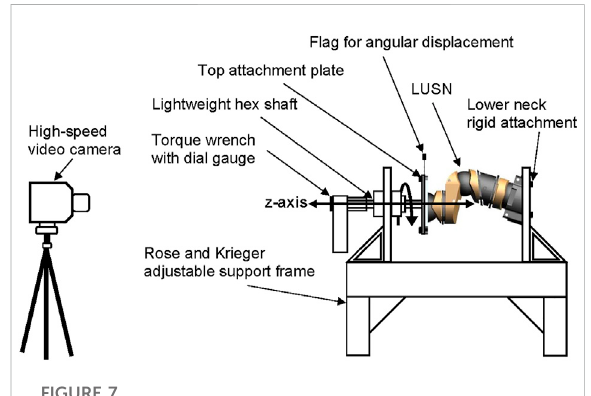
Schematic representation of the axial torque test